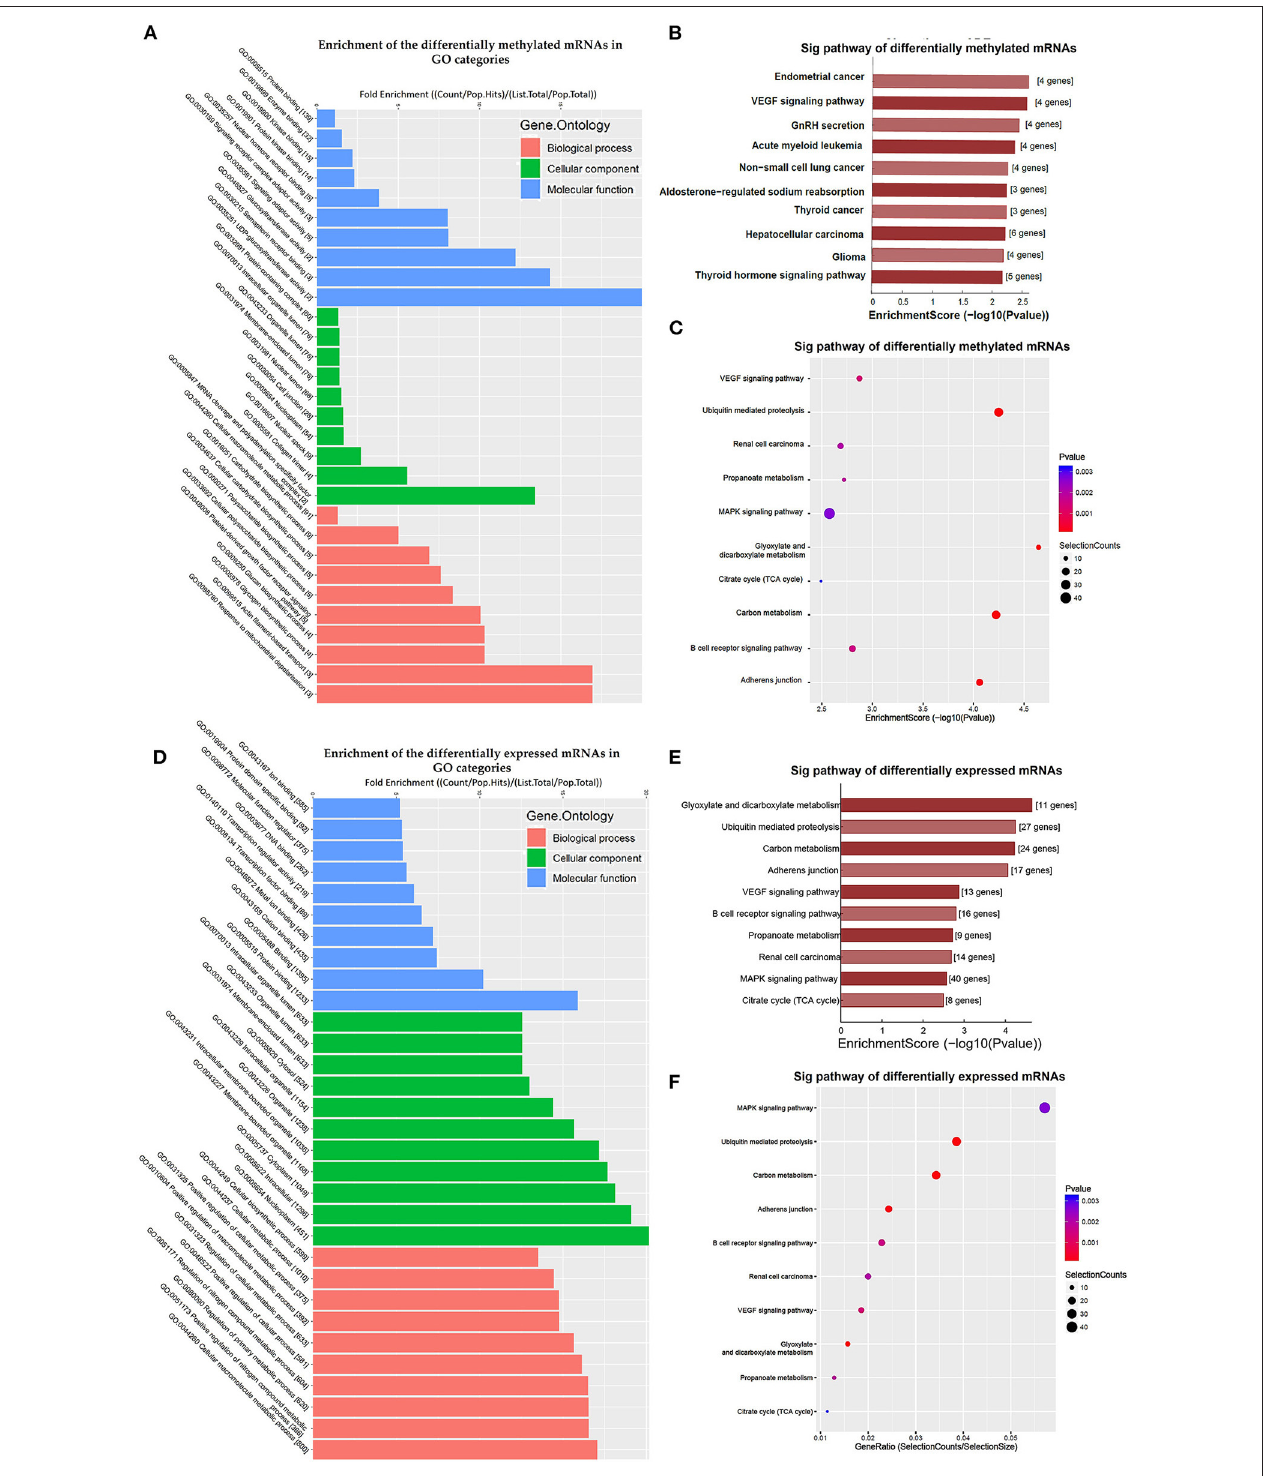
FIGURE 3 | Clustering analyses of the differentially methylated mRNAs through Gene Ontology (GO) function and Kyoto Encyclopedia of Genes and Genomes (KEGG) pathway. (A) Enrichment of the differentially methylated mRNAs in GO categories such as biological process (BP), cellular component (CC), and molecular function (MF). (B,C) KEGG pathway involvement of differentially m 6 A mRNAs in patients with megaureter (M group) compared with vesicoureteral reflux (VUR, V group). (D) Enrichment of the differentially expressed mRNAs in GO categories such as BP, CC and MF. (E,F) KEGG pathway involvement of differentially expressed mRNAs in patients with the M group compared with the V